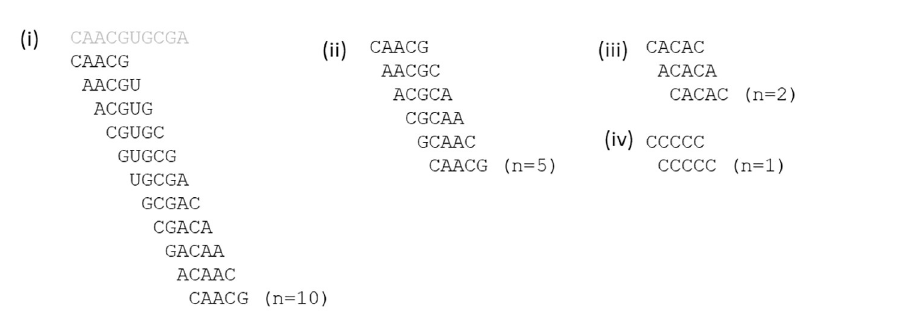
Fig 6. (i) A circular path of 10 steps formed from words taken from a virtual circular genome of length 10. (ii) A circular path of length 5 existing in a mixture in which all 5-mers are present. (iii) and (iv) Short circular paths arising when there is a repeating structure in the 5-mer